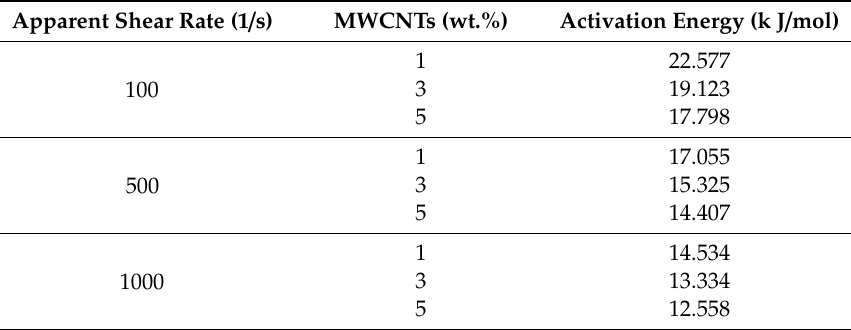
Figure 3. Dependence of melt shear viscosity on temperature and apparent shear rate for ( a ) 1 wt.% and ( b ) 5 wt.% of MWCNTs. Table 2. Flow activation energy based on Arrhenius equation.